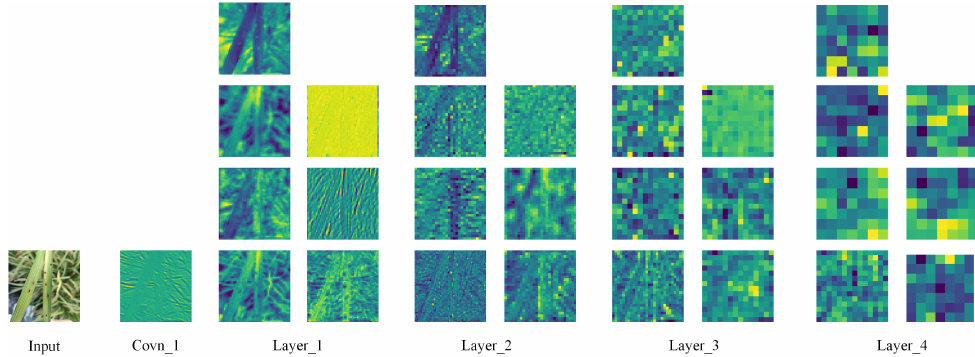
Figure 20. ResNet-50 forward propagation feature